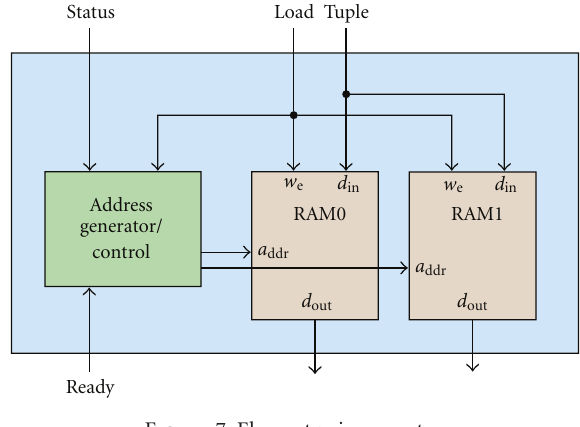
Figure 7: Element pair